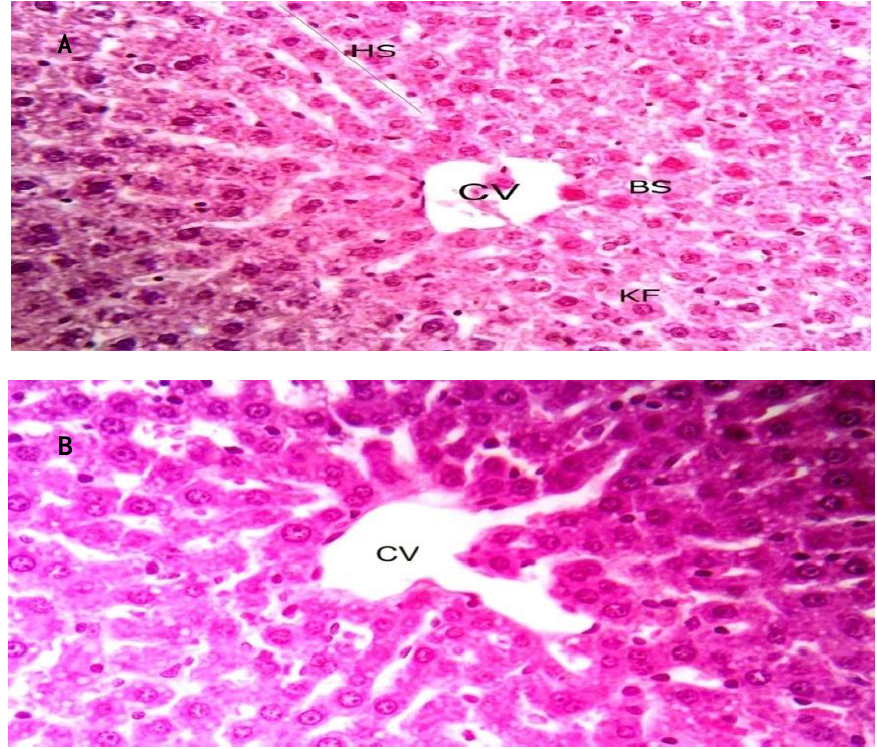
Figure 6. Liver sections from male Albino rats, X400. ( A ); control and ( B ) treated with OXBS by oral route. CV: central vein, HS: hepatic stand, BS: blood sinusoids, and KF: Kupffer cells.